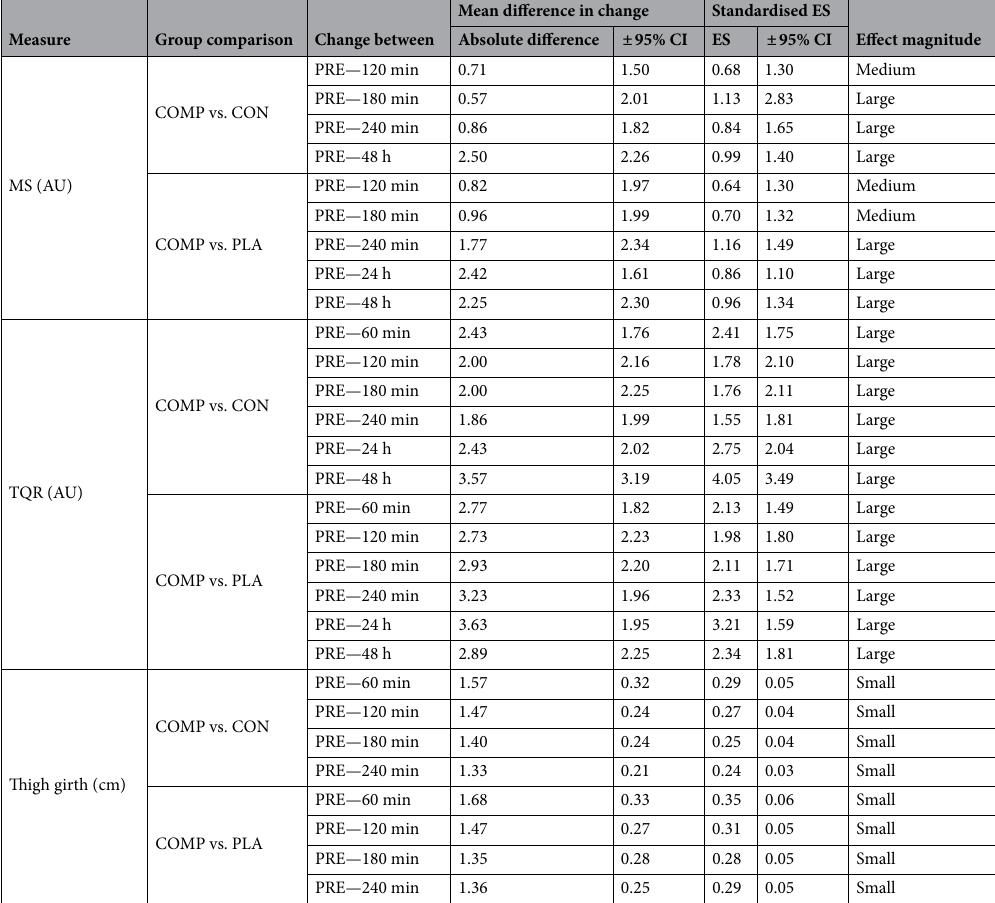
Table 6. Summary of all between-group effects for MS, TQR and thigh